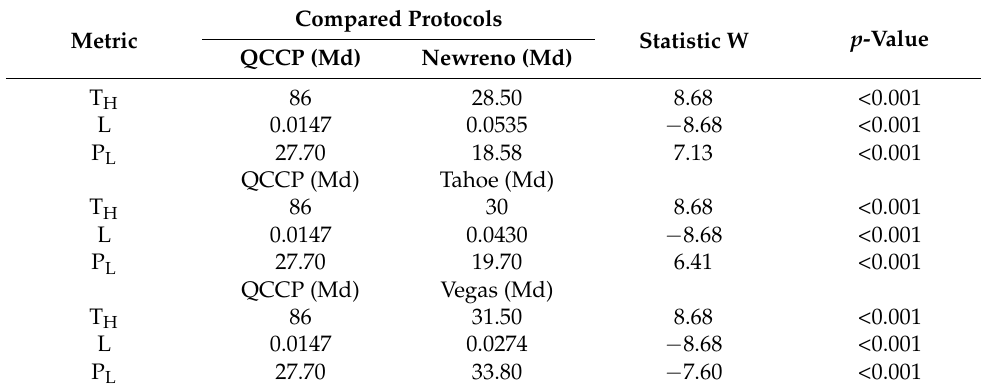
Table 6. Wilcoxon test